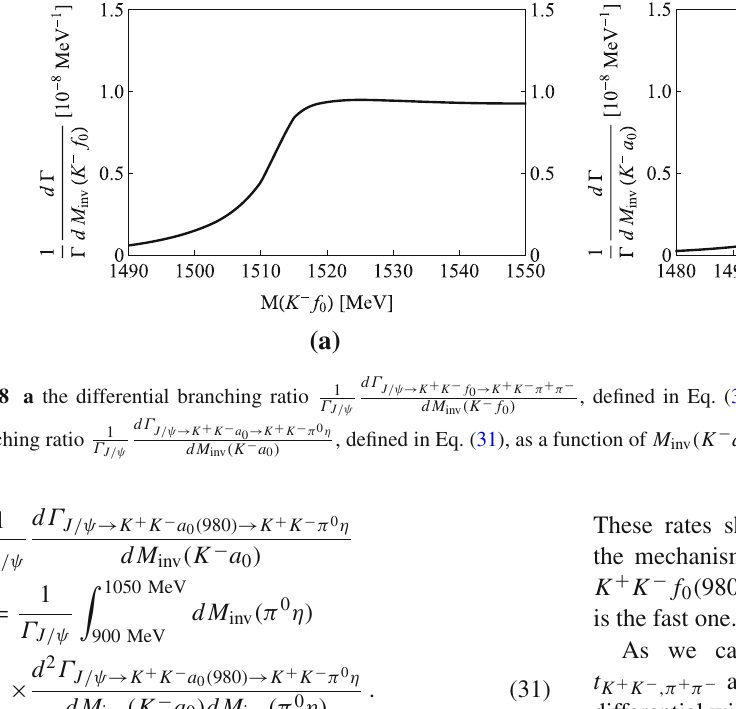
d 2 Γ J /ψ → K + K − f + K − π + π − Fig. 7 a 1 Γ 0 → K as a function of M inv (π + π − ) . b 1 Γ dM inv ( K − f 0 ) dM inv (π + π − ) J /ψ black, and blue curves are obtained by setting M inv ( K − f 0 / K − a 0 ) = 1496 MeV, 1516 MeV, and 1536 MeV, respectively